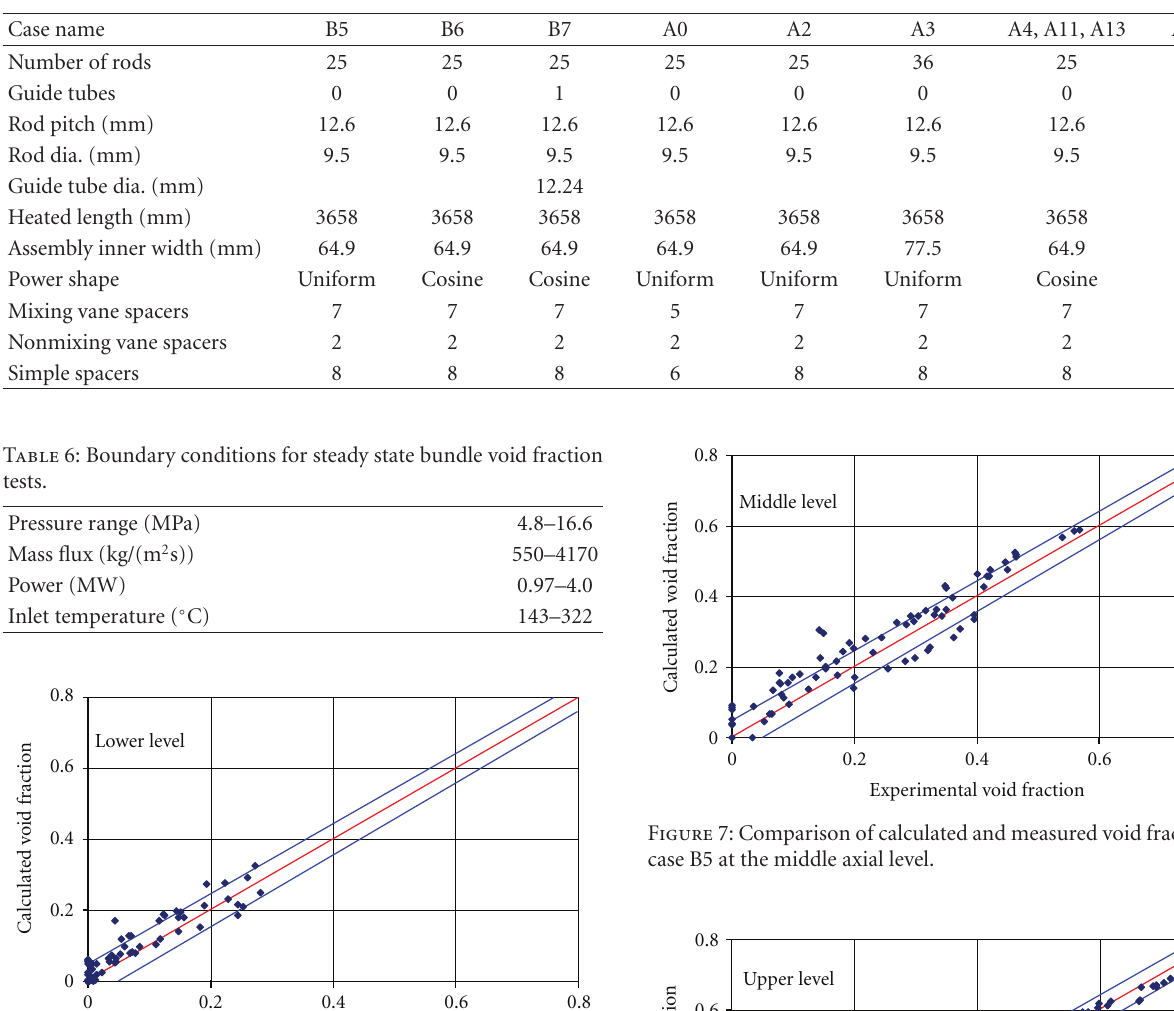
Table 5: Geometry of test bundles for void and DNB measurements.